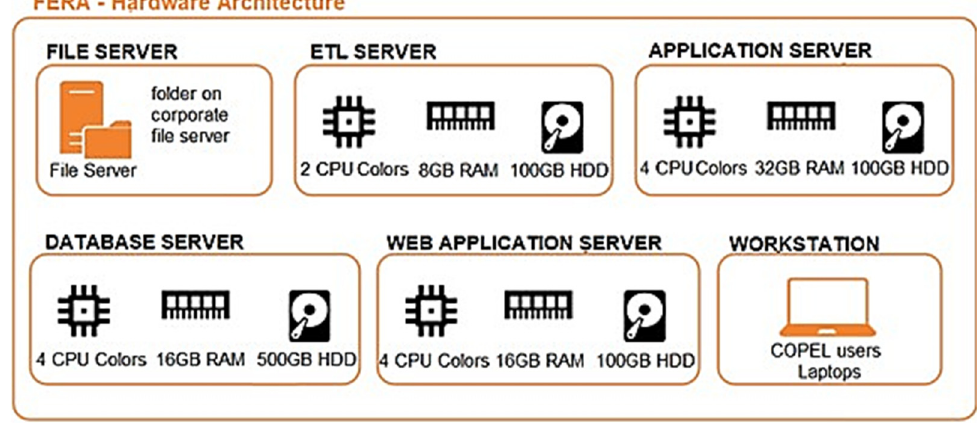
Figure 20. View of the hardware architecture used to execute the components of the FERA [authors].